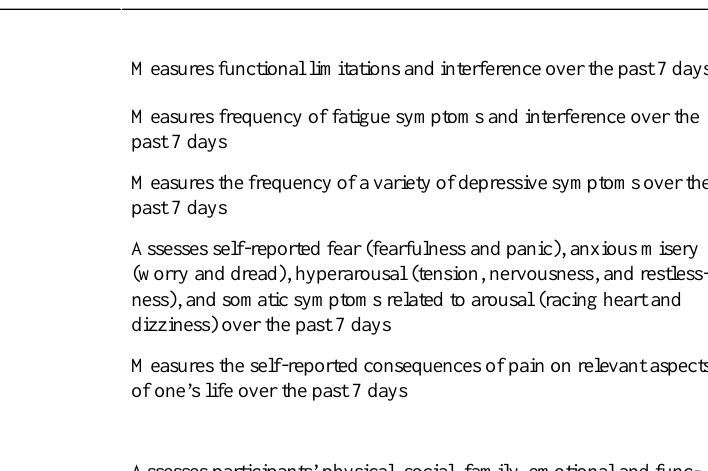
Table 1. Study questionnaires. DescriptionConstruct and